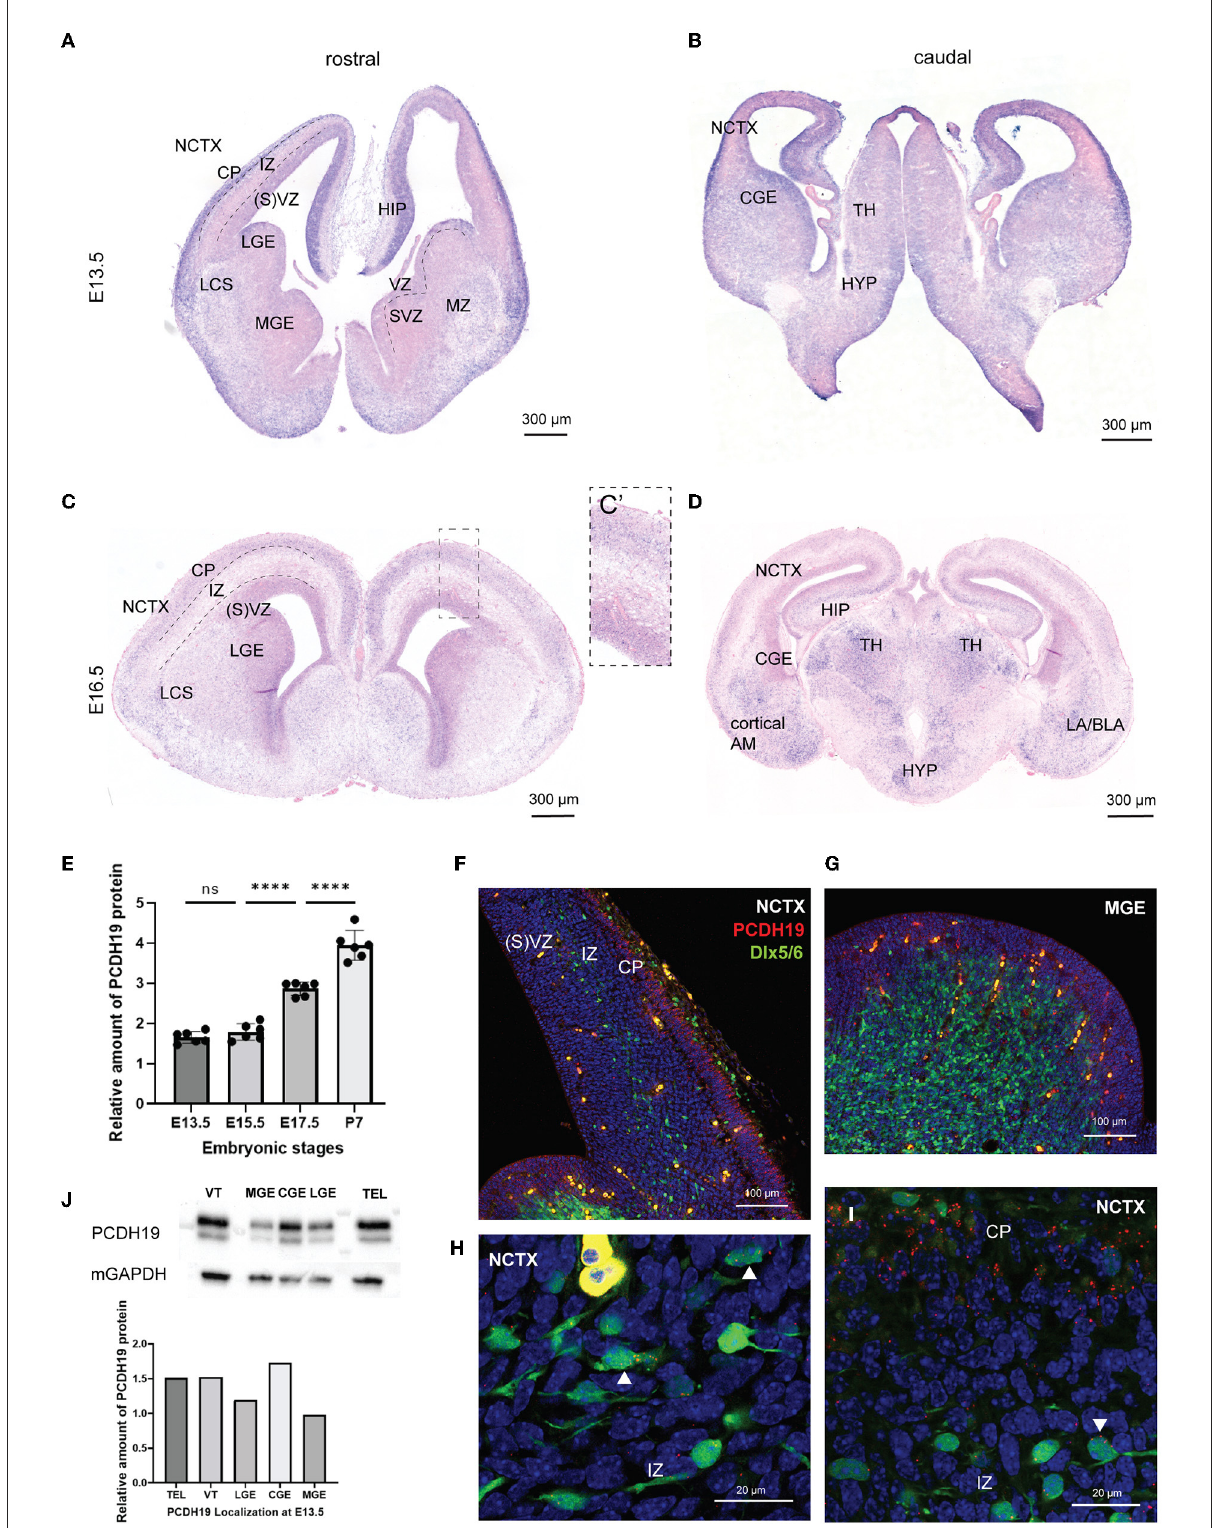
FIGURE1 Pcdh19 is expressed in the developing mouse forebrain and in a subset of the cortical interneurons. (A–D) Pcdh19 mRNA was detected in coronal sections of a wild-type mouse at E13.5 (A,B) and E16.5 (C,D) . (A) At E13.5, ISH of Pcdh19 showed high expression within the CP,